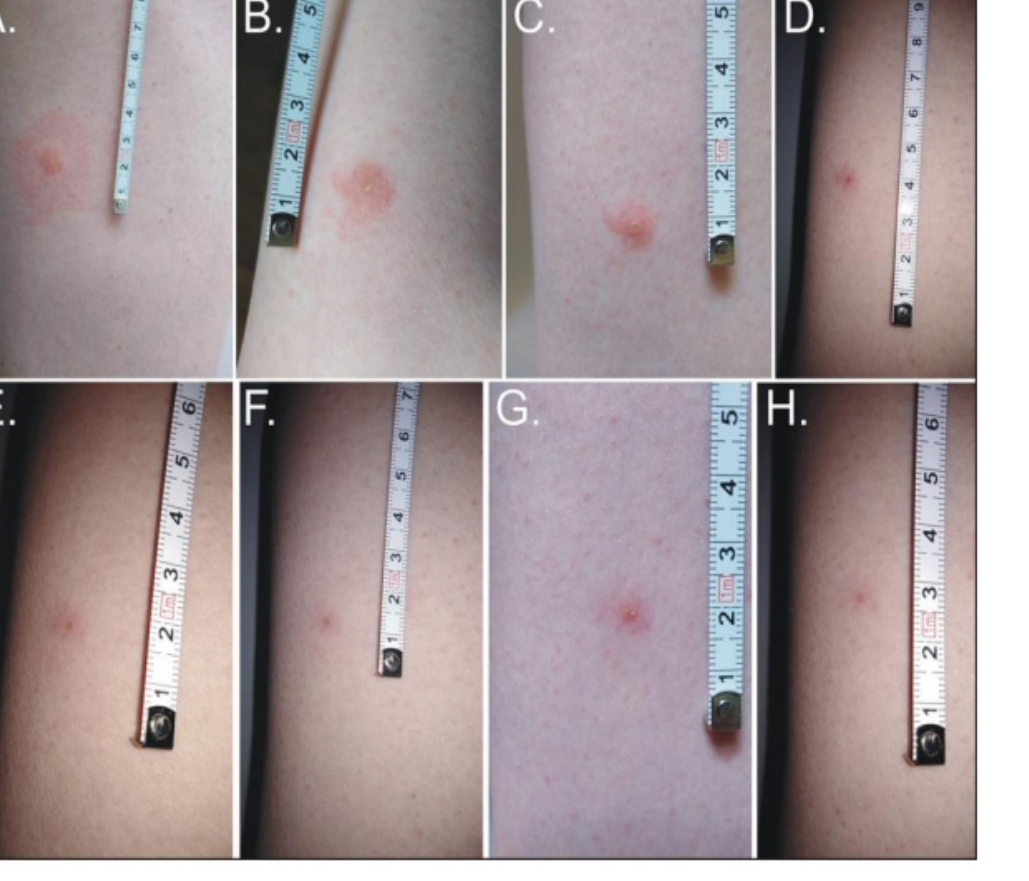
Figure 3. Evolution of skin lesions after Hippobosca equina bite. ( A , B ) Multiple painful urticarial pink papules on an erythematous base on the thigh: ( A ) regular 19 h after the bite; ( B ) 40 h after the bite; ( C ) excoriated erythematous papule with self-limited dermatitis 64 h after the bite; ( D ) 99 h after the bite; ( E ) 131 h after the bite; ( F ) 196 h after the bite; ( G ) 260 h after the bite, ( H ) residual hyperpigmented papule 19 days after the bite (photos by Weronika Ma ś lanko).